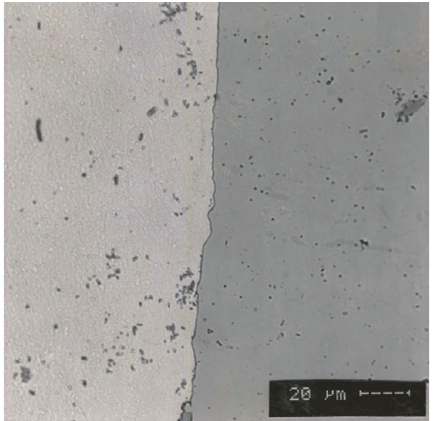
Figure 5: The microstructure in the bonding zone of the friction welded AlMgSi0.5 aluminium alloy-X10CrNiTi189 austenitic steel joint (according to